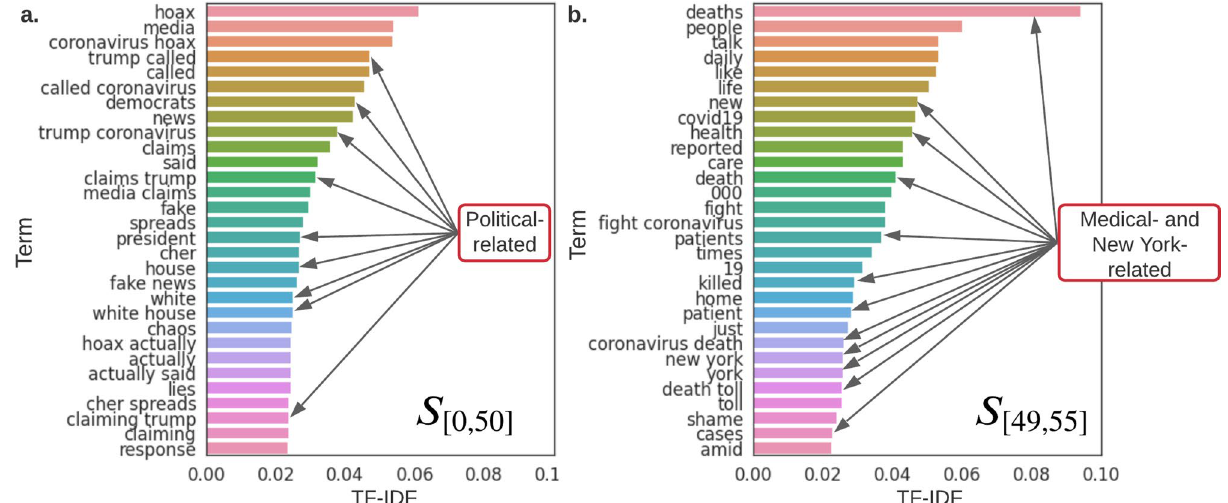
Figure 5. Top words in S [ 0,50 ] ( a ) and S [ 49,55 ] ( b ). Top words are the words with the highest TF-IDF scores and represent the most influential and important words/topics in sentences. We take n = 1 and 2 for n-grams, therefore, in the results there exist unigrams and bigrams. We find that sentences that survived from day 0 to 50 mainly discussed political-related topics, and sentences that survived from day 49 to 55 are more discussing non-political- or medical-related topics. Specifically, 75.31% in S [ 0,50 ] , and 41.50% in S [ 49,55 ] are discussing political-related topics, respectively. This shift of topic may in fact is the reason for cyclical behavior of probability of attachment we discovered in Fig. are deleted at the end of one network evolution cycle. This distinct misinformation network behavior cannot be explained by conventional network models, and may be caused by the rapid attention shift characteristic of social media as we discussed. We further investigate several hot topics in order to validate the above-mentioned hypothesis on misinfor- mation network evolution. We manually inspect the sentences that survived in the network from day 0 to day 50, noted as S [ 0,50 ] . Since S [ 0,50 ] are all deleted from the network on day 51, and considering our misinformation network construction method, there will be no new links attached to S [ 0,50 ] . We also study sentences collected on day 49 that managed to survive to day 55, denoted by S [ 49,55 ] . We compare the top words , i.e., the words with highest TF-IDF (term frequency-inverse document frequency 47 ) scores, in S [ 0,50 ] and S [ 49,55 ] as shown in Fig. 5. We find that political words appear the most in the top 30 words of S [ 0,50 ] (e.g., “Trump”, “president”, “white house”-related phrases appear about 9 times). In comparison, no political words exist in S [ 49,55 ] ’s top 30 words. This evidence shows that public attention shifts from political-related content to non-political in the time period we investigated. Furthermore, we find that “New York”-related phrases along with medical words such as “deaths”, “killed”, “patients”, “cases” represent the majority of the top 30 words of S [ 49,55 ] . Which matches the COVID-19 break out in New York from April 18 th to 24 th . These examples confirm that our network construction method with node deletion mechanism can capture the actual misinformation network evolution. In addition, our net- work formulation is more sensitive to rapid network changes, e.g., the public attention shift, than classical PA or fitness-based network models. Prediction. Deep learning methods accurately predict in real time, which Twitter posts are the central nodes in the misinformation network. Complex network measures such as centrality are calculated based on network topology, i.e., adjacency matrix. However, these metrics are highly computationally expensive and require the adjacency matrix information. In this work, we construct misinformation networks where nodes are sentences, hence, we hypothesize that network measures can be predicted by deep learning and natural language process- ing (NLP) methods by considering as inputs only the sentences (without adjacency matrix). We verify that complex network metrics of misinformation networks can be easily predicted with high accuracy using deep neural networks (DNNs). In our centrality prediction, to predict day(s) t’s central nodes, we take daily mis- information networks from day t=0 up to day t-1 as training data, and the trained DNN outputs predictions for day(s) t. Specifically, we perform 1-day, 5-day, and 10-day prediction, meaning that for example, in 5-day prediction, if we predict central nodes from day 20 to day 25, we take daily misinformation networks from day 0 to day 19 as training data. In addition, instead of feeding DNN with adjacency matrix, we utilize techniques from natural language processing and feed the DNN with sentence embeddings, specifically, BERT embeddings (training setup can be found in Methods section “Deep learning-based misinformation network measures pre- diction”). Throughout this process, there is no need to run time-consuming network analysis algorithms, and DNNs predict network measures with high accuracy in real time. Specifically, in 1-day prediction, our DNN predicts degree centrality, closeness centrality, and betweenness centrality, with 94.19 ± 0.03% , 94.25 ± 0.04% , 83.25 ± 0.22% accuracies, and 98.54 ± 0.01% , 98.47 ± 0.01% , 90.44 ± 0.21% AURoCs, respectively, as shown in Fig. 6. The key contributor to this outstanding result is the extracted natural language features in rumors. We believe that the trained neural network learns the syntactic and semantic patterns of influential tweets. This find- ing enables real time misinformation combat by online identification of fast-spreading and influential misinfor-